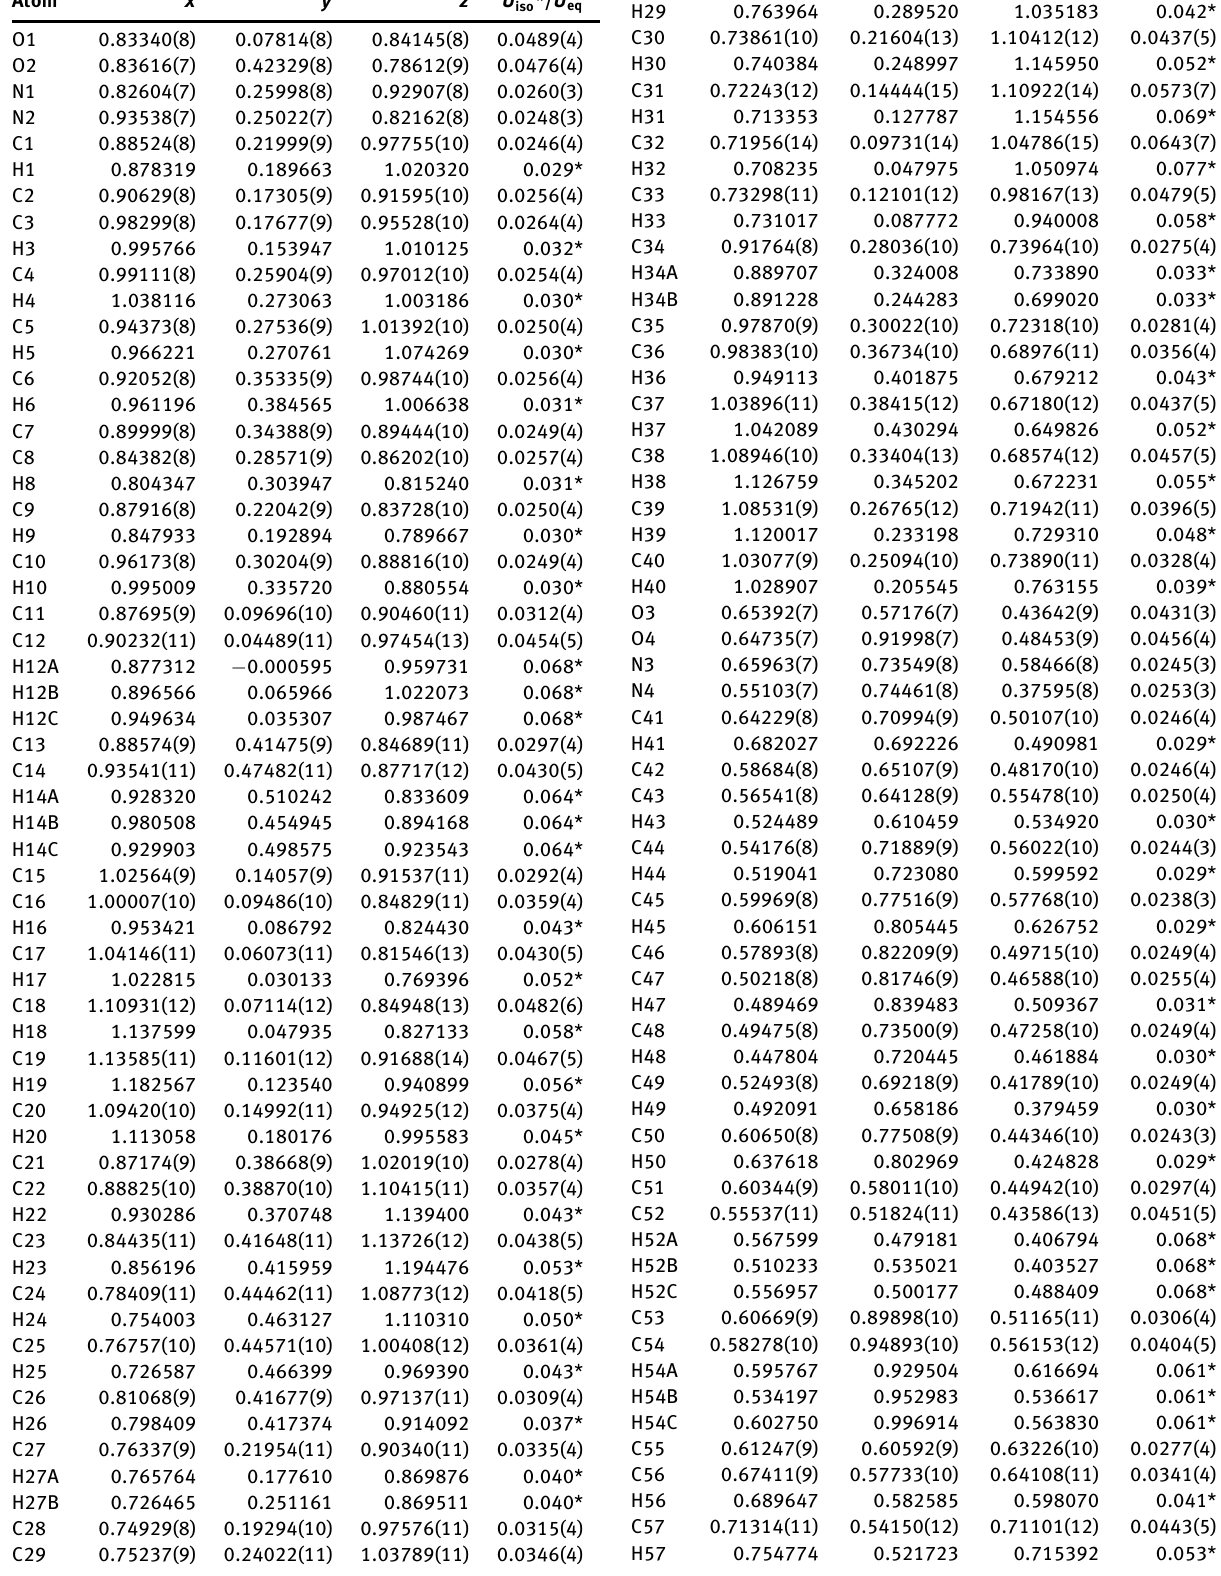
Table 2: Fractional atomic coordinates and isotropic or equivalent isotropic displacement parameters (Å 2